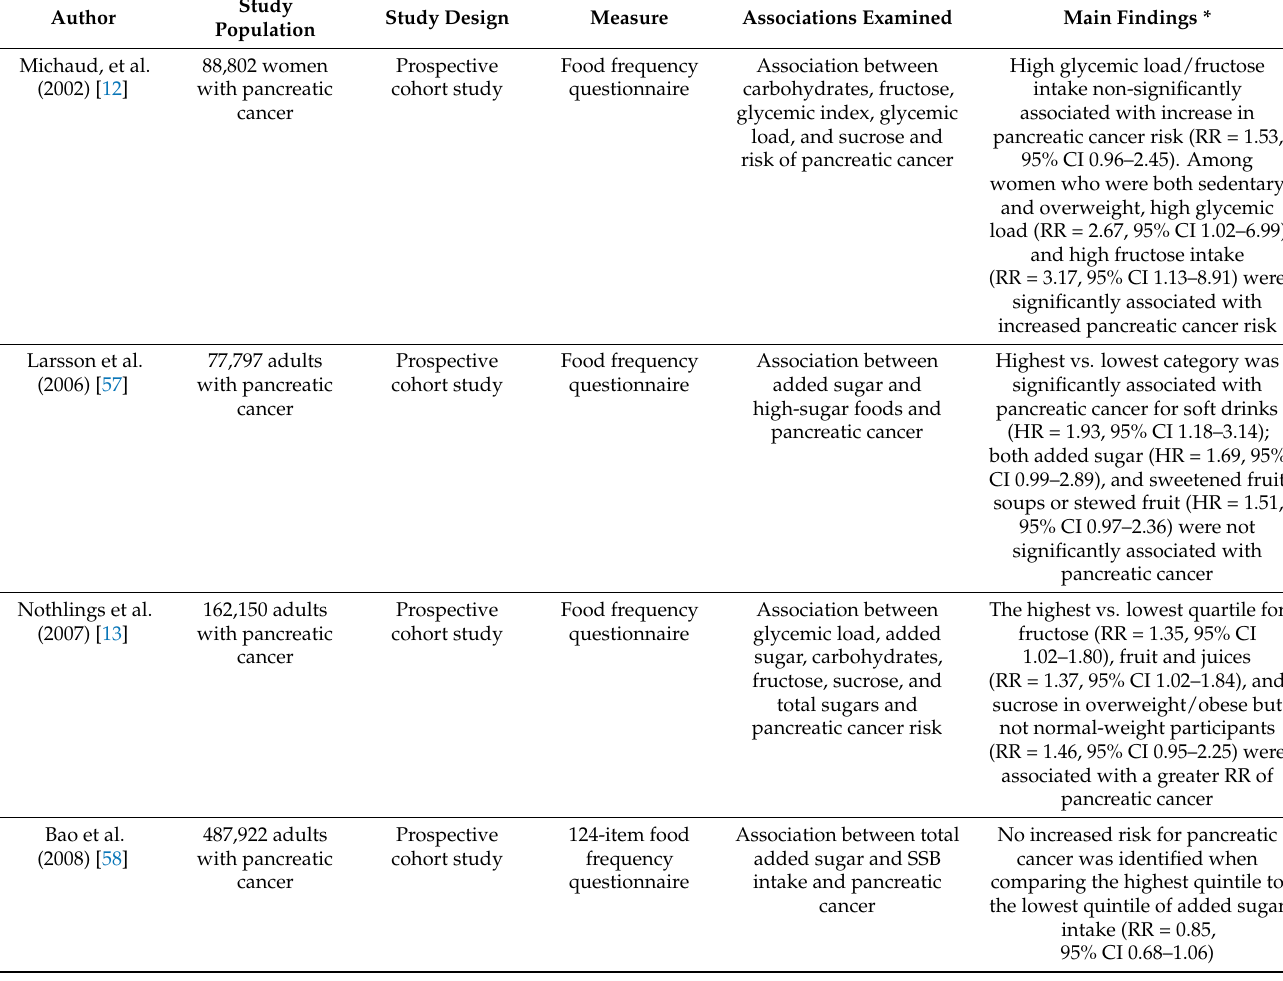
Table 3. Added sugar intake and risk of developing pancreatic cancer and